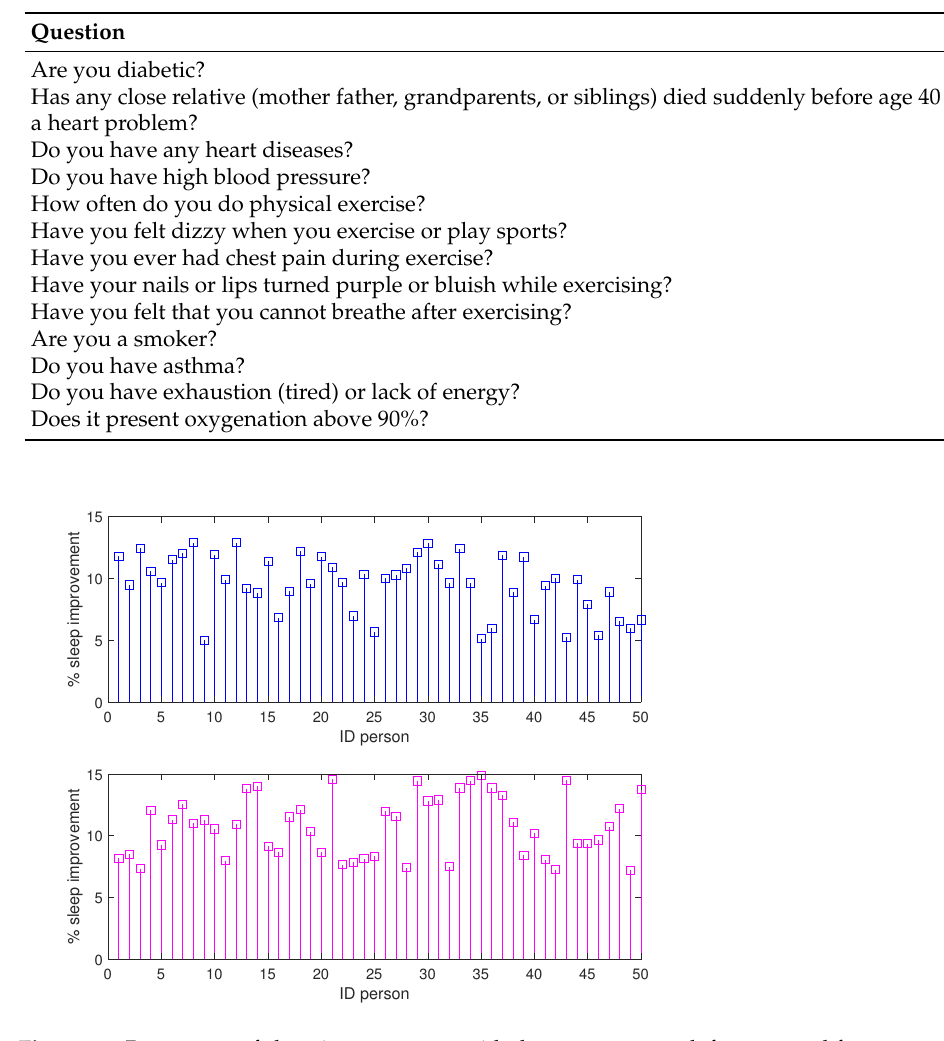
Figure 16. Percentage of sleep improvement with the sensor network for men and for women. Figures 17 and 18 show examples of actual testing in a user’s dream application. Scenario A shows the person’s sleep behavior without the sensor network in the person’s room. Scenario B shows an example of the person’s sleep performance with the sensor network in the person’s room. We can observe the improvement of the person’s sleep quality with the sensor network, even in the number of hours of